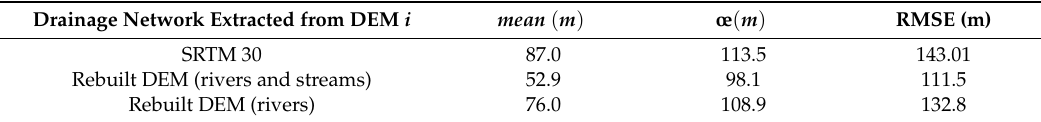
Table 3. Mean, standard deviation ( σ ), and RMSE of the horizontal distances between the points of each drainage under study (the original, the rebuilt with OSM rivers and streams, and the rebuilt with OSM rivers), and the reference drainage network.